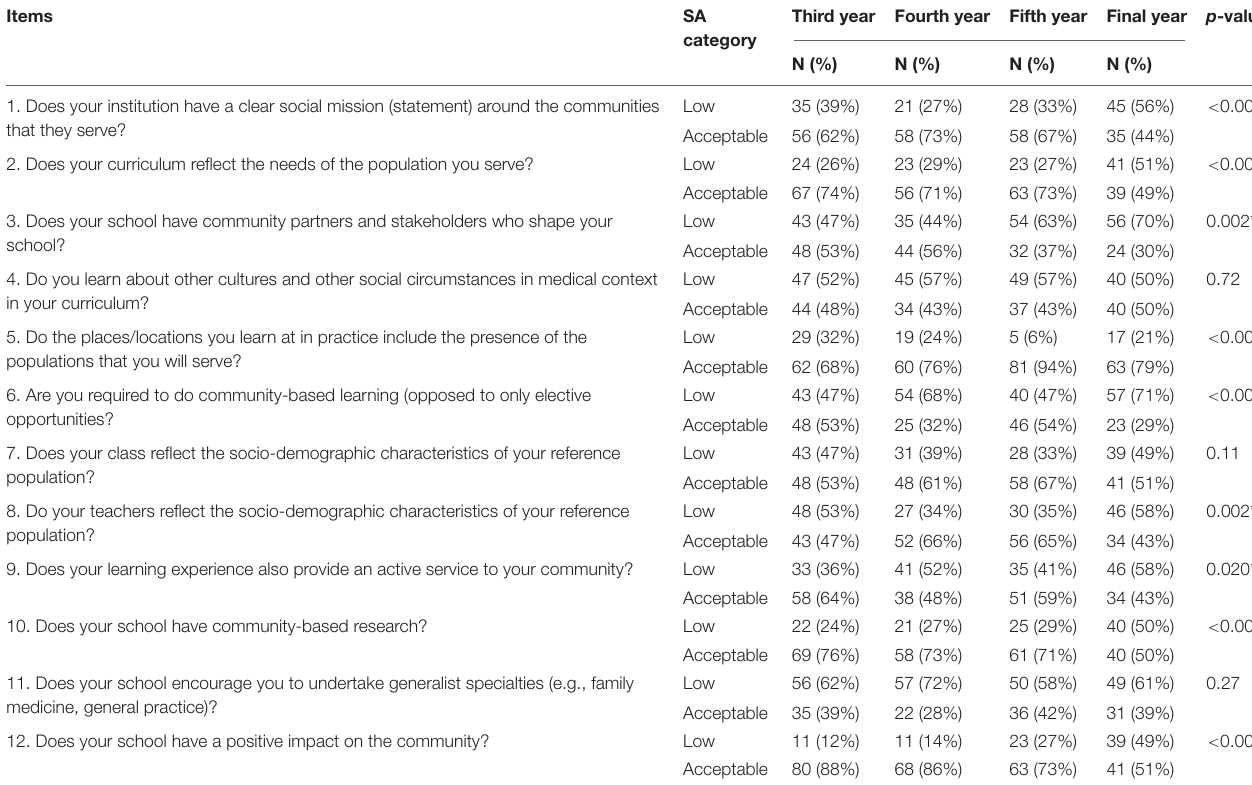
TABLE 4 | Association of the 12 items determining SA with the year of study.